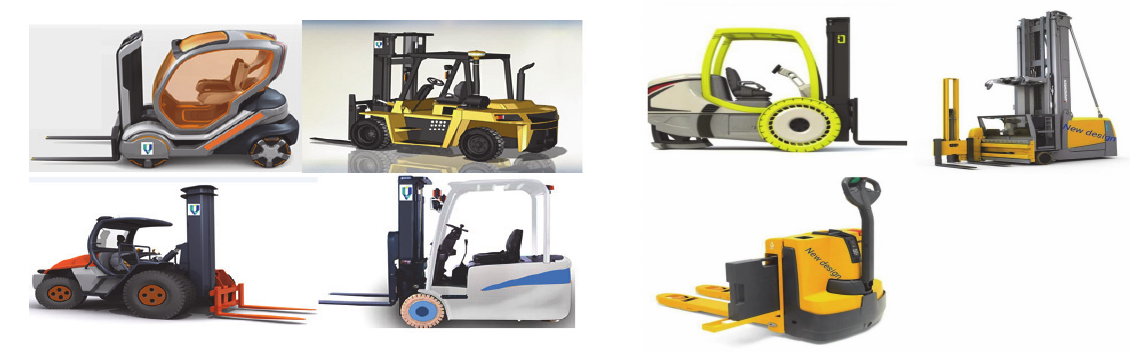
Fig. 2. Concept designs for a Forklift